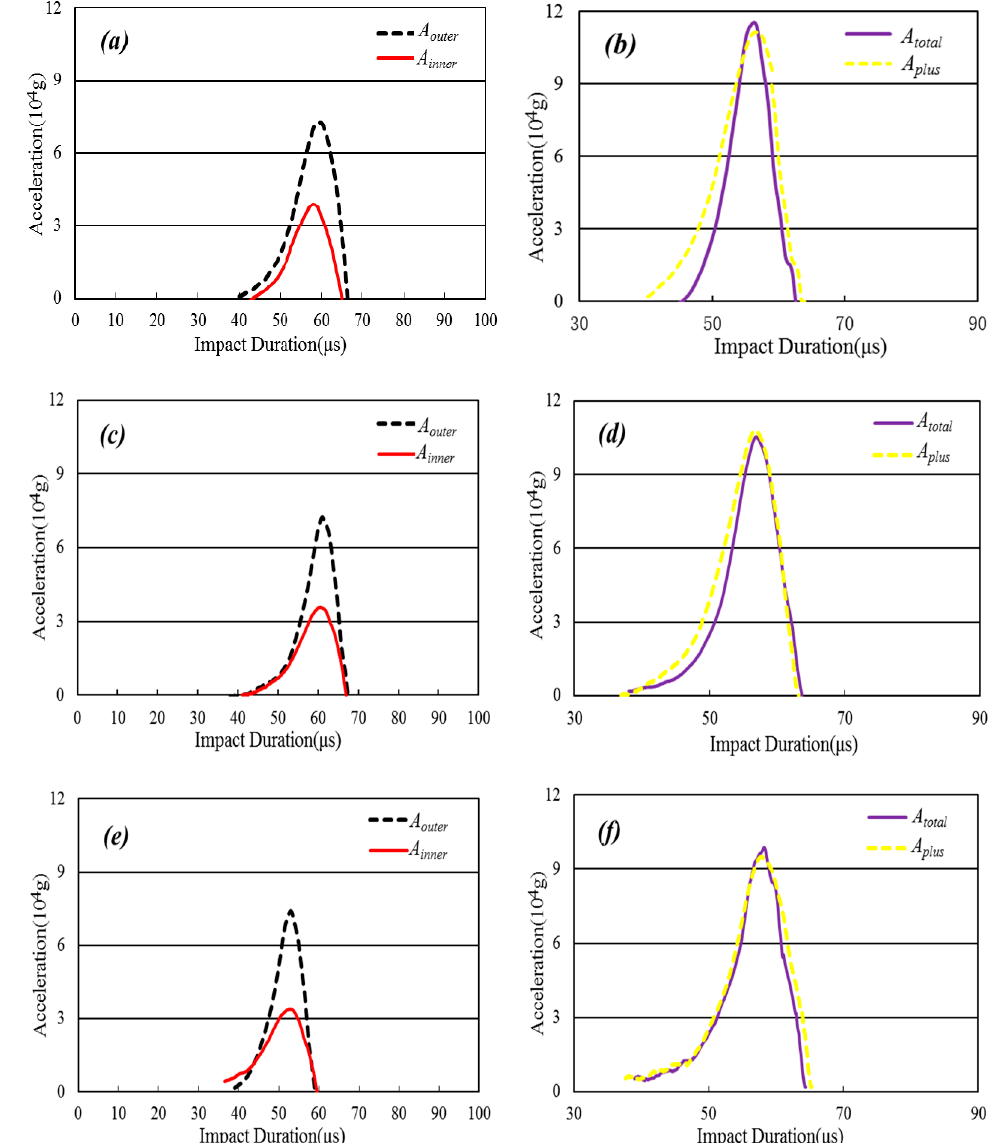
Figure 6. Accelerations as a function of the impact duration for the impact system, determined from the outputs of the accelerometers impacted by inner ( solid lines ) and outer bullets ( dotted lines ) (( a ), ( c ), and ( e )), and by both simultaneously ( solid line ) in ( b ), ( d ), and ( f ). The dotted lines in ( b ), ( d ), and ( f ) represent the sums of the accelerations of the inner and outer bullets in ( a ), ( c ), and ( e ), respectively.